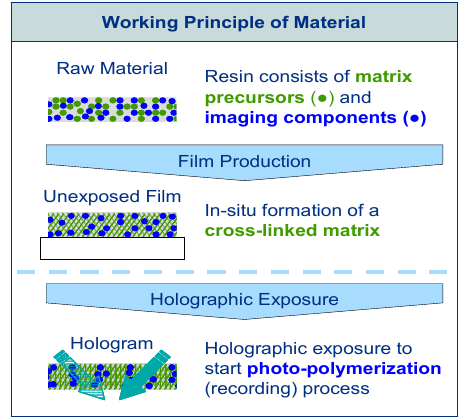
Figure 1. Working principle of Bayfol ® HX film photopolymer [17]: Matrix precursors and imaging components form the raw material resin. The matrix precursors are cross-linked to form a stable matrix system hosting the imaging components during film production. This film product is stable until exposed to light. The film is exposed to suitable light to initiate the photo-polymerization that forms the hologram structure during the recording